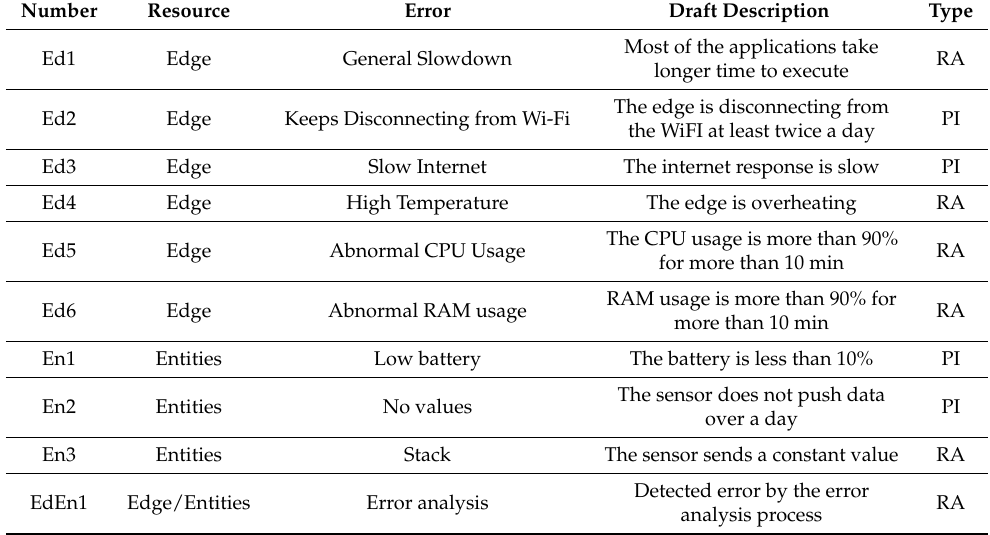
Table 3. Common problems/malfunctions and healing